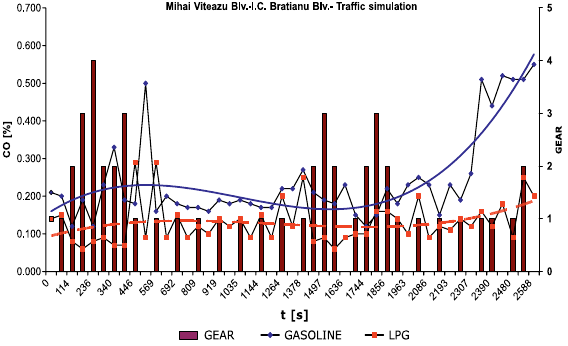
Fig. 14. Compared CO emission versus time (air conditioning unit is turned off) for petrol/LPG fuel